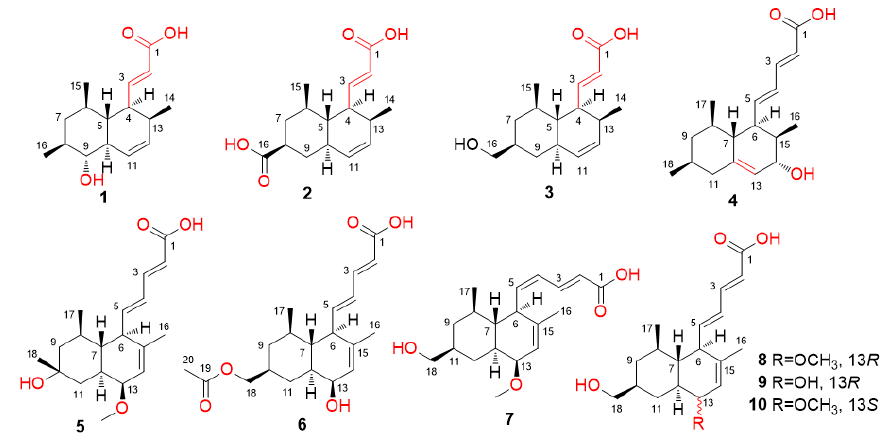
Figure 1. Structures of compounds 1 – 10